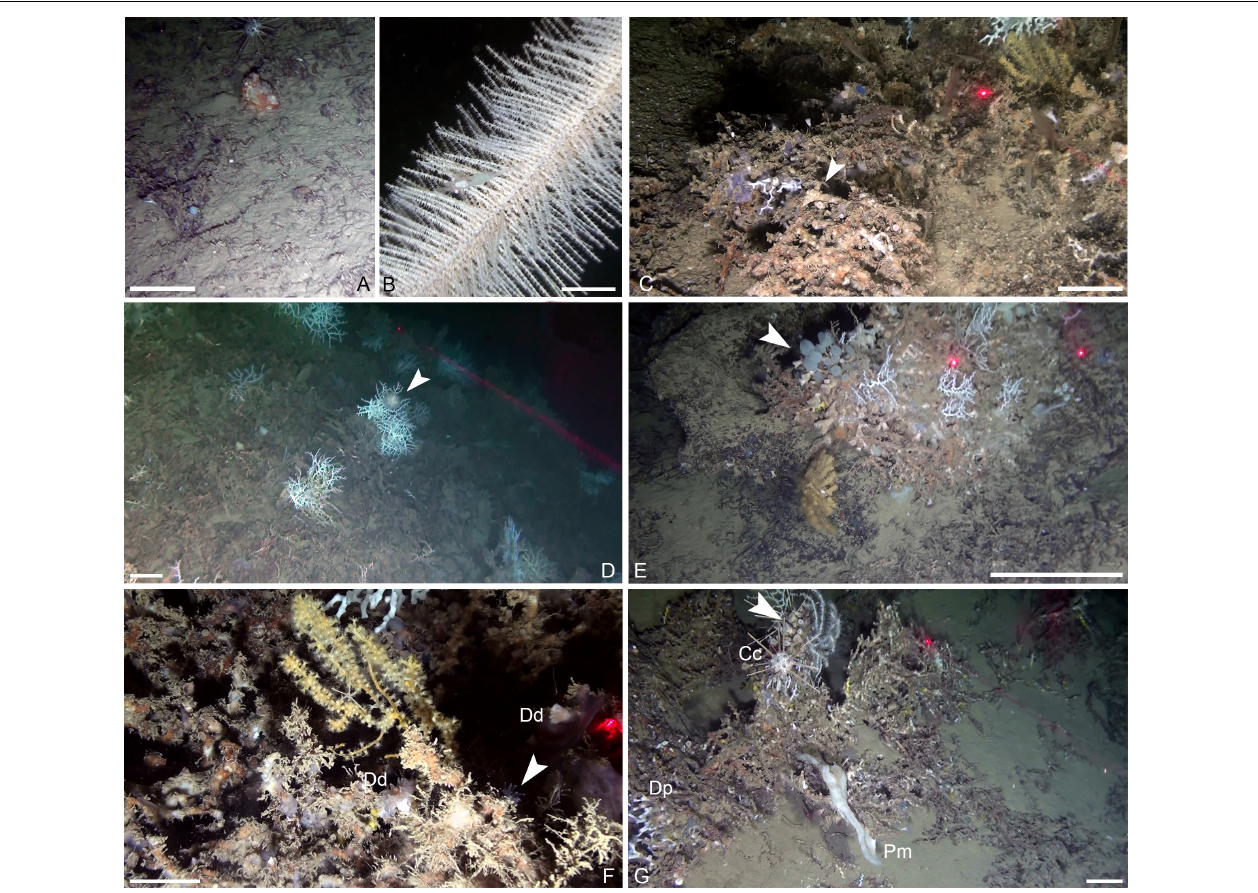
FIGURE 7 | The vagrant Octopus salutii on muddy coral rubble at Site B (A) , bar = 10 cm; (B) detail of Stylocheiron sp. on Parantipathes larix (Site A), bar = 3 cm; (C) arrow indicates the carnivorous coralliophilinid Hirtomurex squamosus feeding on a dead coral frame, bar = 5 cm; (D) isolated Madrepora oculata bushes on dead frames, arrow pointed at Echinus cf. melo grazing on M. oculata , bar = 20 cm; (E) the rare lollipop sponge Sympagella delauzei (arrow) associated with Desmophyllum dianthus and Acanthogorgia hirsuta , bar = 20 cm; (F) close-up on cnidarian assemblage with juvenile D. dianthus (Dd) and A. hirsuta with grazing undetermined nudibranch (arrow), bar = 5 cm; (G) dead coral frames colonized by the large fan-shaped sponge Pachastrella monilifera (Pm), juvenile Desmophyllum pertusum (Dp, on the left) and a cluster of the solitary Desmophyllum dianthus (arrow), the echinoderm Cidaris cidaris (Cc) grazing on a coral frame, bar = 10 cm. Panels (C–G) all from Site